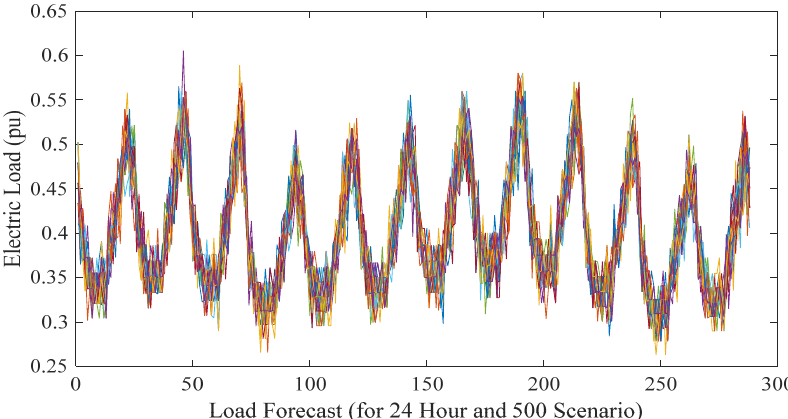
Figure 9. Electricity demand prediction using LSTM.